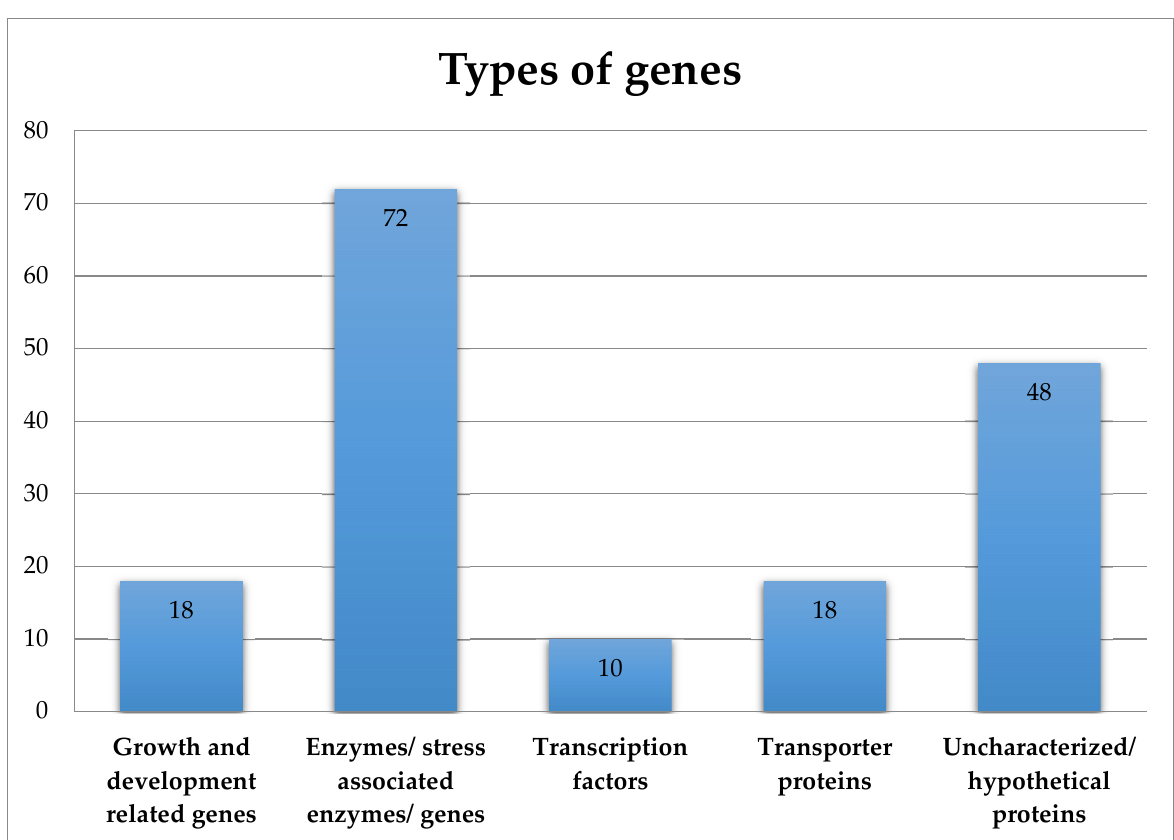
Figure 3. Types of candidate genes linked with the longevity-associated SNPs.